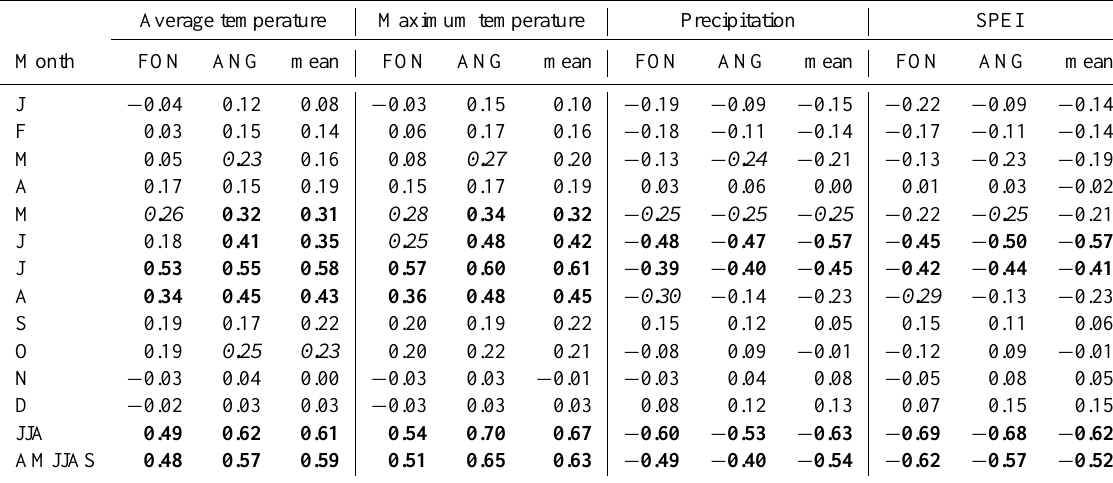
chronology R 2 = 0 . 38. The standard deviation of the differ- ences between modeled and observed SPEI (0.72 for FON; 0.70 for ANG; 0.71 for the mean chronology) defines the confidence interval for the reconstructions (Fig.